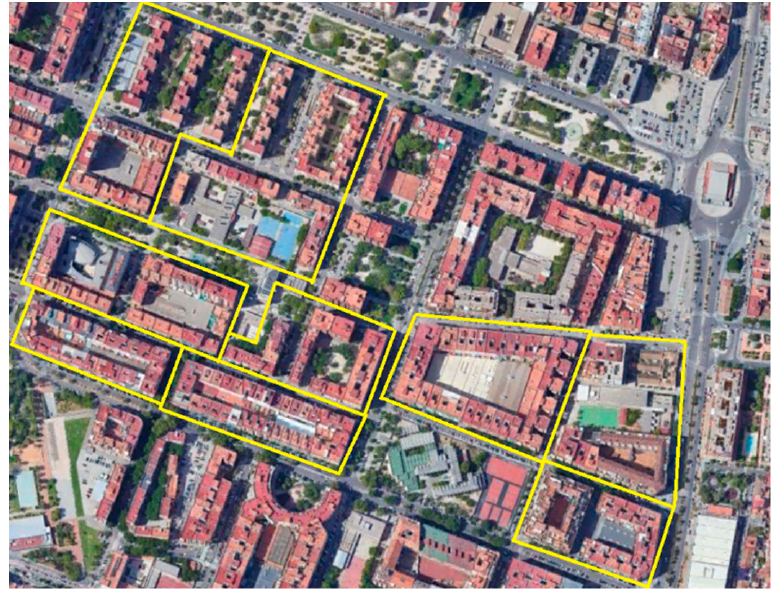
Figure 8. Fuel cell distribution areas covering the demand.